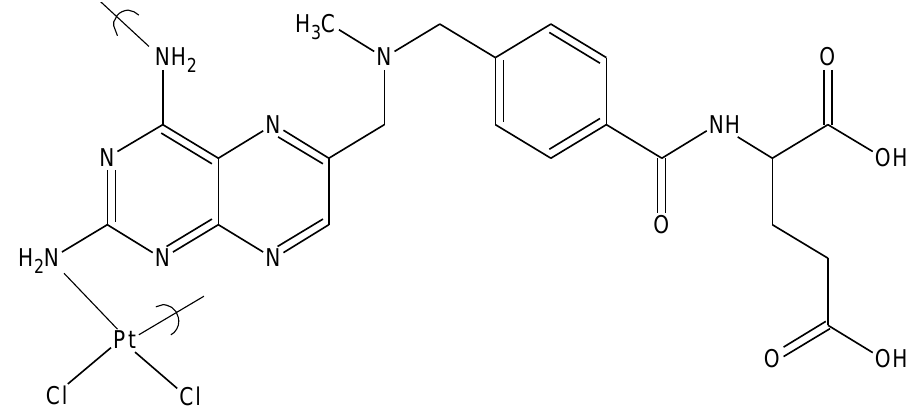
Figure 12. Repeat unit for the product of methotrexate and tetrachloroplatinate